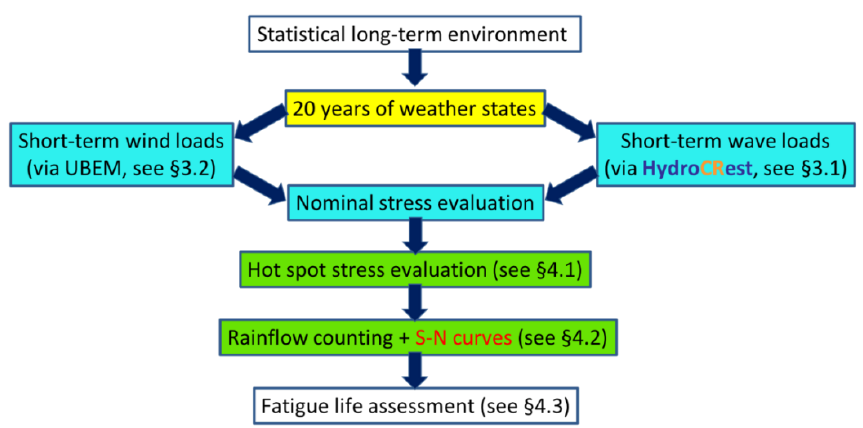
Figure 1. Flowchart of the methodology; UBEM and S – N curve denote the unsteady blade element momentum method and the stress-cycle curve, respectively.